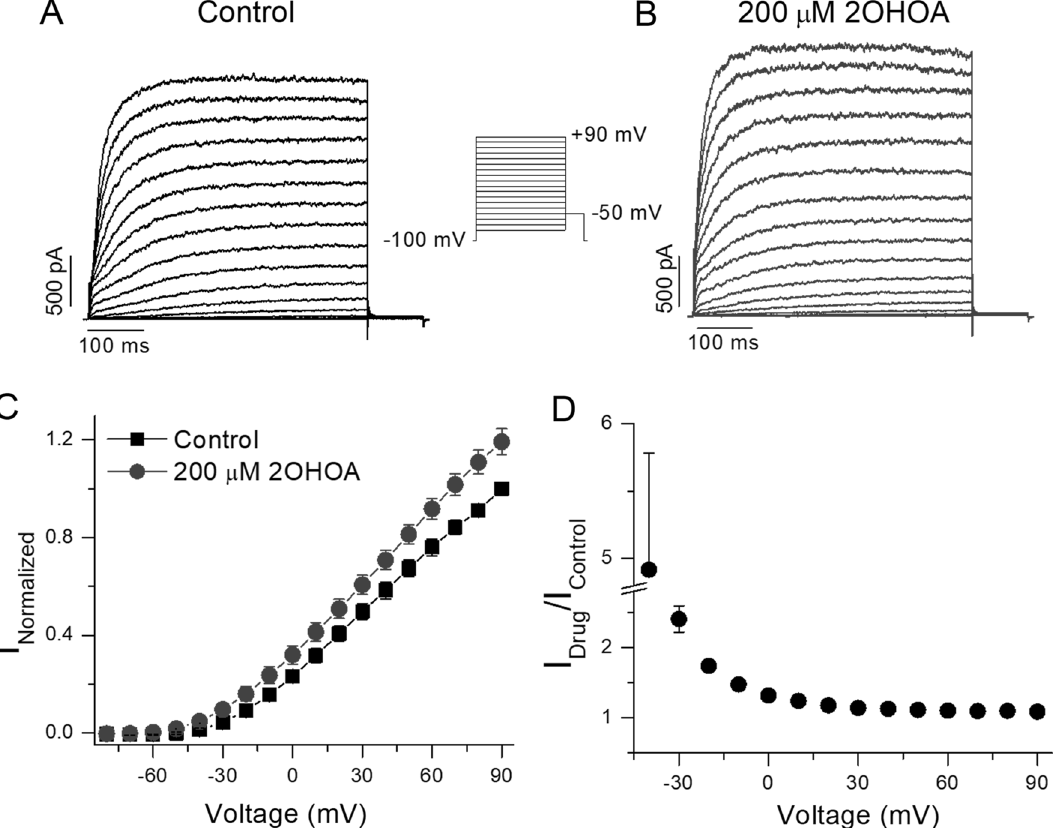
Fig. 1 2OHOA increases Kv10.1 currents in a voltage‑dependent manner. A , B Representative recordings of Kv10.1 currents before ( A ) and after application of 200 µM 2OHOA ( B ), from the same cell. Currents were evoked by 500 ms depolarizing steps to test potentials ranging from ‑80 to 90 mV in 10 mV increments from a holding potential of ‑100 mV. C normalized I‑V relationships for currents measured at the end of the + 500 ms pulses before (squares) and after 2OHOA (circles). D Kv10.1 current increase by 2OHOA plotted as a function of the test potential. Data are represented as mean SEM ( n 13 ± =